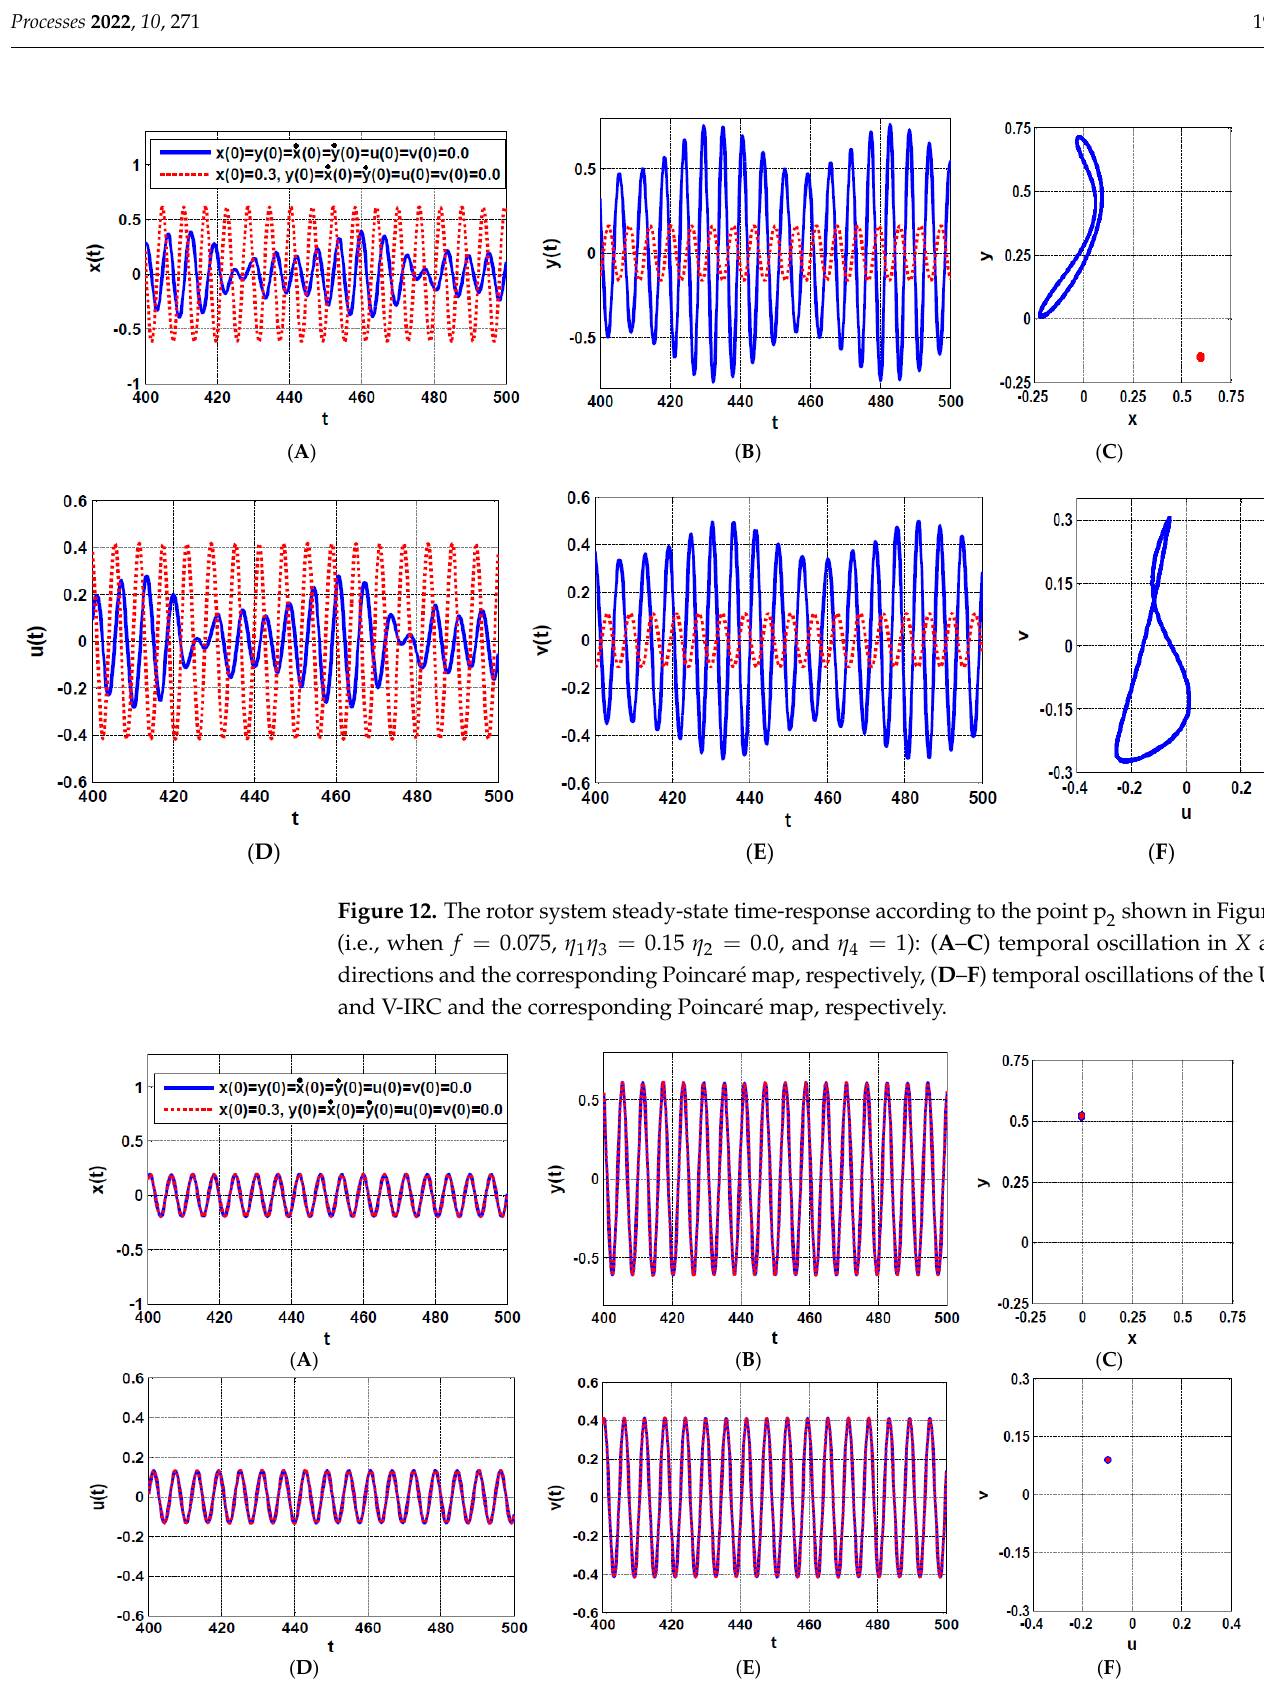
Figure 13. The rotor system steady-state time-response according to the point p 3 shown in Figure 10B (i.e., when 𝑓 = 0.075 , 𝜂 1 𝜂 3 = 0.25 𝜂 2 = 0.0, and 𝜂 4 = 1 ):( A – C ) temporal oscillation in 𝑋 and 𝑌 directions and the corresponding Poincaré map, respectively, ( D – F ) temporal oscillations of the U-IRC and V-IRC and the corresponding Poincaré map, respectively.